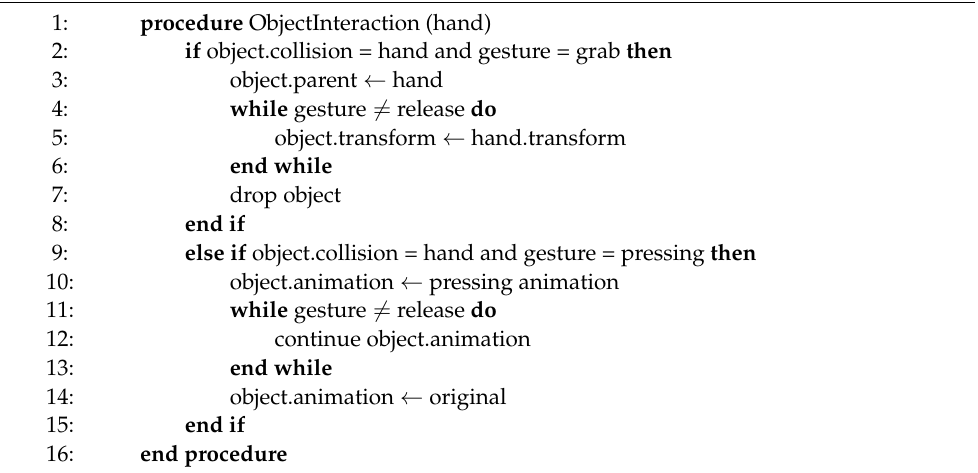
Algorithm 2. Object interaction based on hand